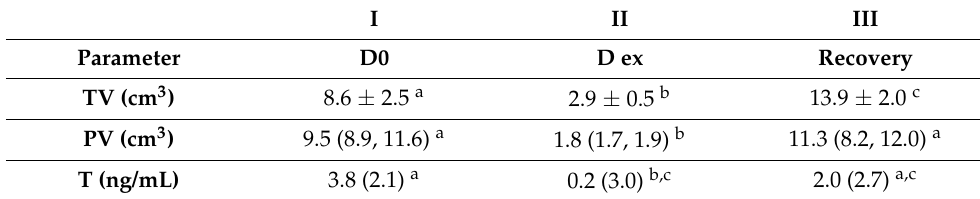
Table 1 Comparative results of testicular volume (TV), prostate volume (PV), and testosterone (T) I. prior to treatment (D0), II. on D ex (before implant removal and hemicastration) and III. at the end of the observation period (recovery) for animals treated with a 4.7 mg deslorelin implant (TG, n = 6); results are given as mean ± SD (TV), median (Q1, Q3) (PV), and x ̅ g (DF) (T).